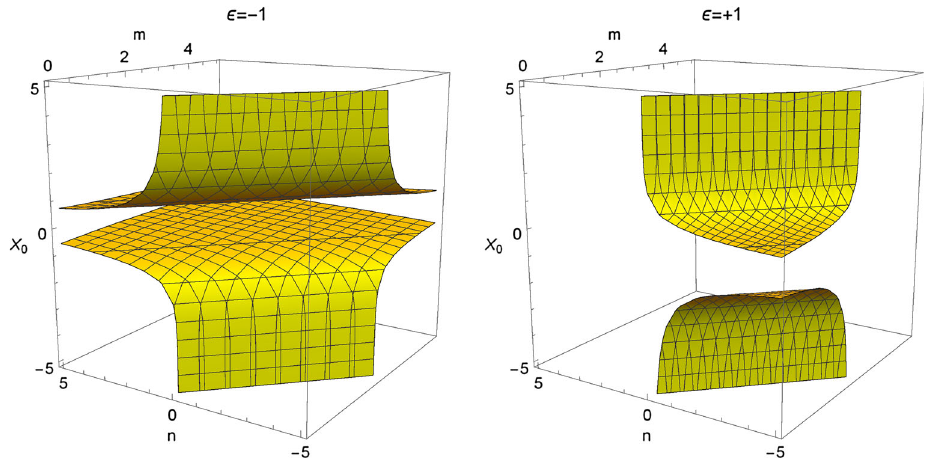
Fig. 1 The variation X 0 versus typical values of the m and n parameters in (43) for the dust background Table 3 BH and its surrounding dust field parameters for (cid:5) = ± 1. For these cases, the positive energy condition is satisfied everywhere in